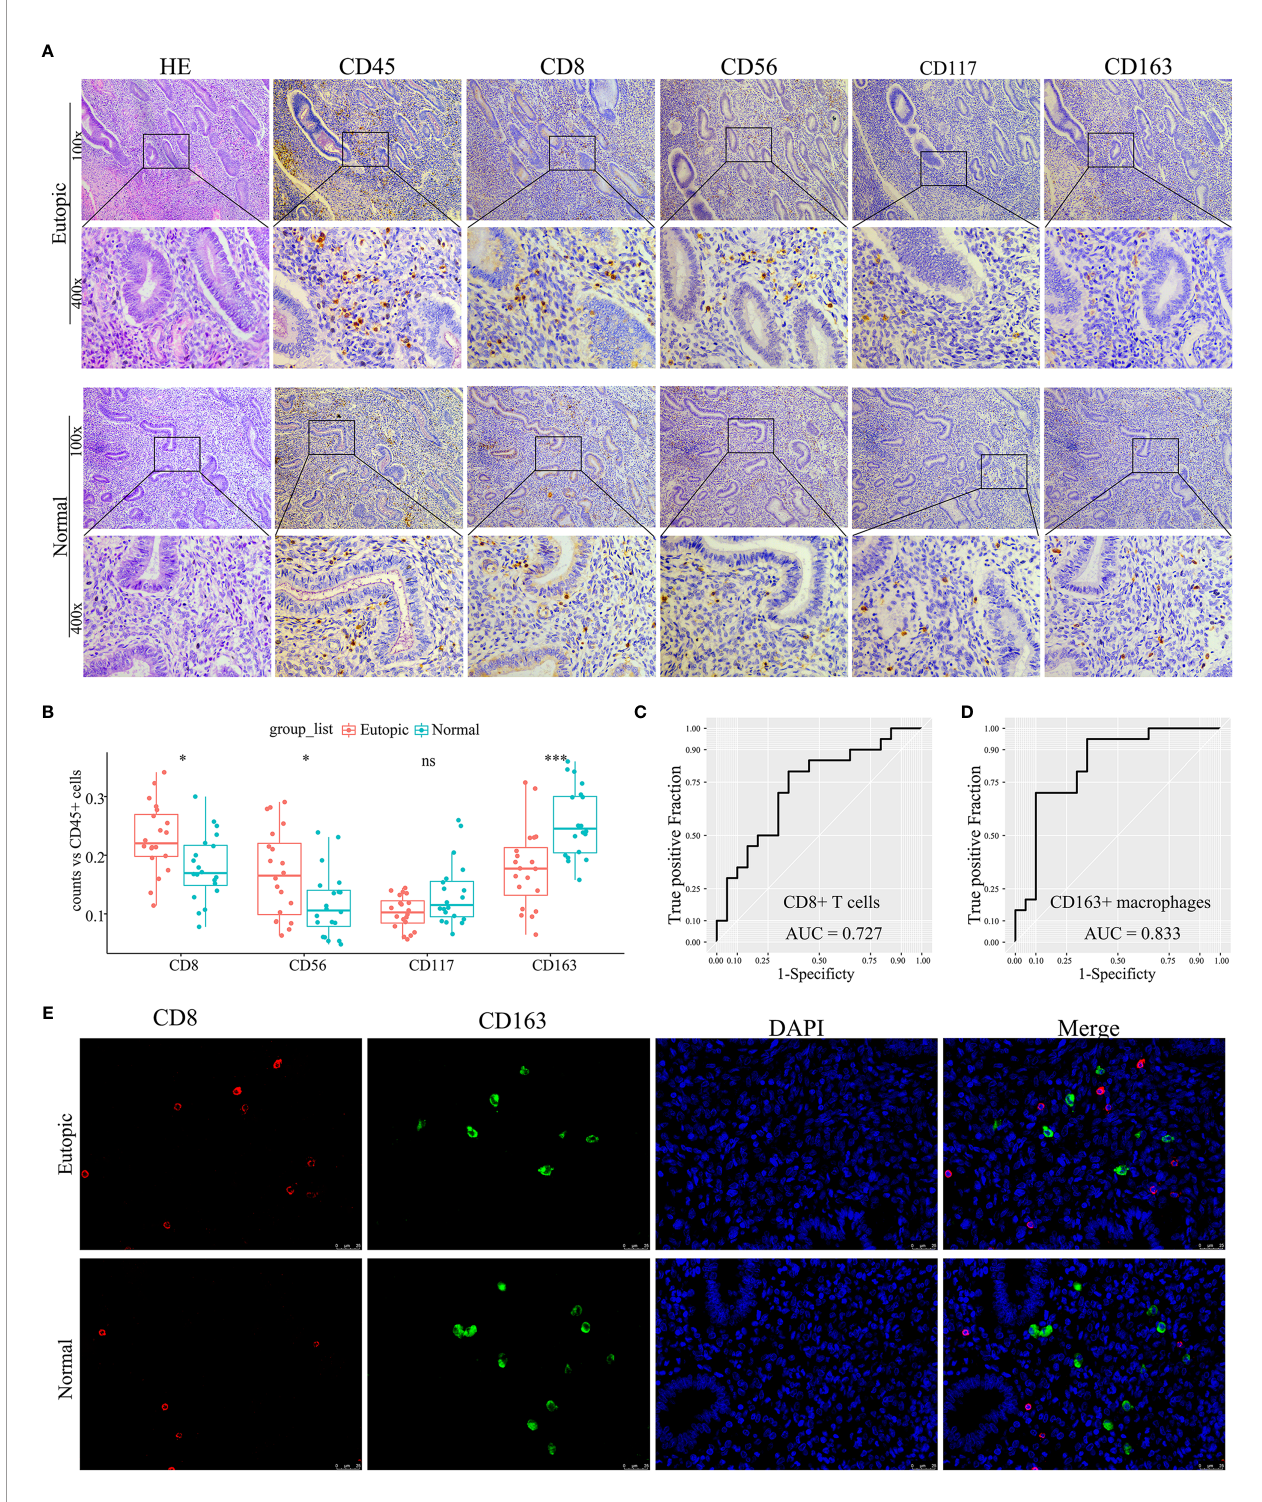
FIGURE 5 | Experimental validation of in fi ltrating immune cells in clinical endometrial samples. (A) Representative photographs of haematoxylin-eosin (HE) staining and immunohistochemistry (CD45, CD8, CD56, CD117, and CD163). Magni fi cations at 100× and 400× are shown. (B) Boxplots comparing the proportions of four immune cell subsets between normal and endometriosis tissues. Data were assessed by the Wilcoxon rank-sum test, and P values are labelled. ns, no signi fi cance. (C, D) The ROC curve of CD8 + T cells and CD163 + macrophages in clinical samples. AUC, the area under the ROC curve. (E) Representative photographs of immuno fl uorescence (CD8, CD163, and DAPI). Magni fi cation was 400×. *P < 0.05, ***P < 0.001, ns, no signi fi